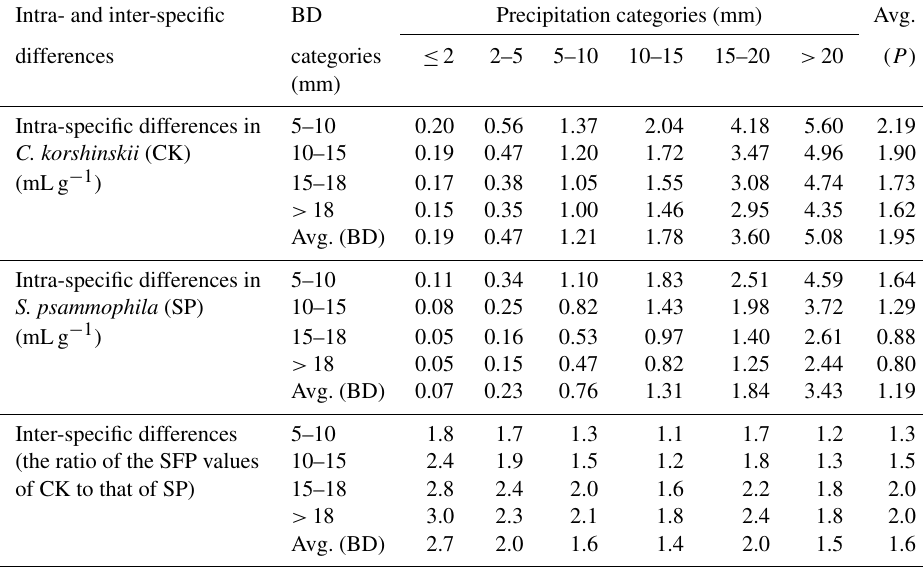
Table 4. Comparison of stemflow productivity (SFP) between the foliated C. korshinskii and S. psammophila . Intra- and inter-specific